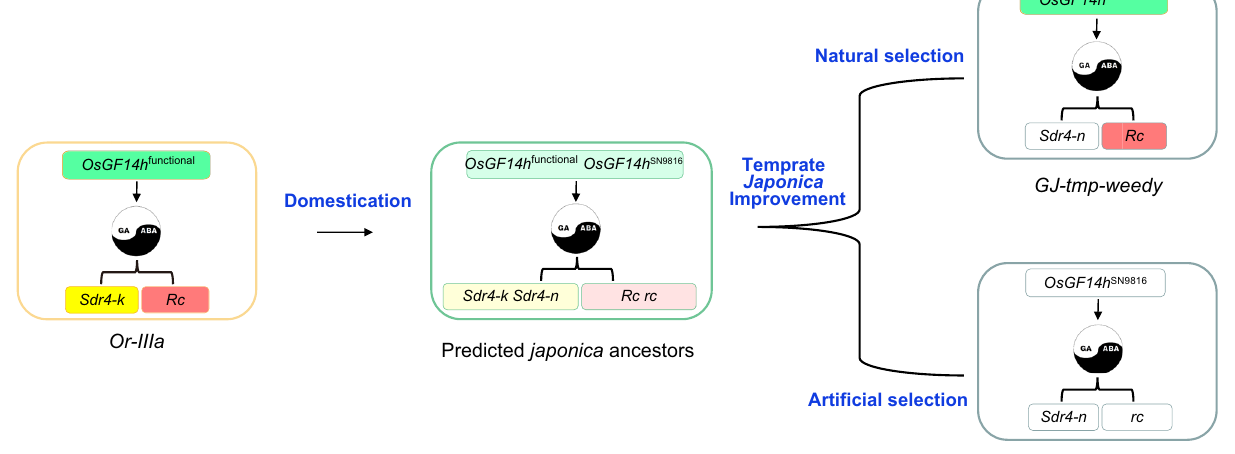
Fig. 8 | Evolutionary model of OsGF14h in Japonica rice. As an ancestral popu- lation, Oryzaru fi pogon ( Or-IIIa )carriesfunctionalallelesof OsGF14h , Sdr4 and Rc as a stable unit to maintain robust germination potential for fl ood adaptation while avoiding pre-harvest sprouting (PHS). Sincethe red pericarpand strong dormancy are unfavorable traits in the temperate japonica planting area, the non-dormancy allele ( Sdr4 -n) and white pericarp allele ( rc ) are gradually fi xed in GJ-tmp-cul by the arti fi cial selection with the genetic improvement of japonica subspecies.